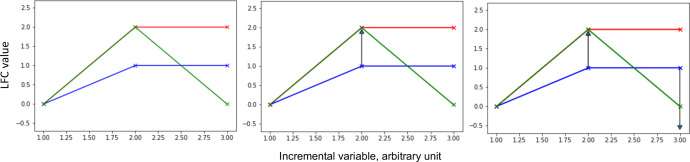
Shape deformation principle applied to the comparison of curves defined by genomic data.This figure illustrates the shape deformation principle, applied to the comparison of curves defined by genomic data, that to map the blue curve onto the red curve (left panel), only one deformation (arrow) is needed, the one illustrated on the middle panel, whereas to map the blue curve onto the green curve (left panel), two deformations (arrows) are needed, including the one illustrated on the middle panel and the one illustrated on the right panel. The length of the arrows is proportional to the cost needed to transform the source curve into the target curve.